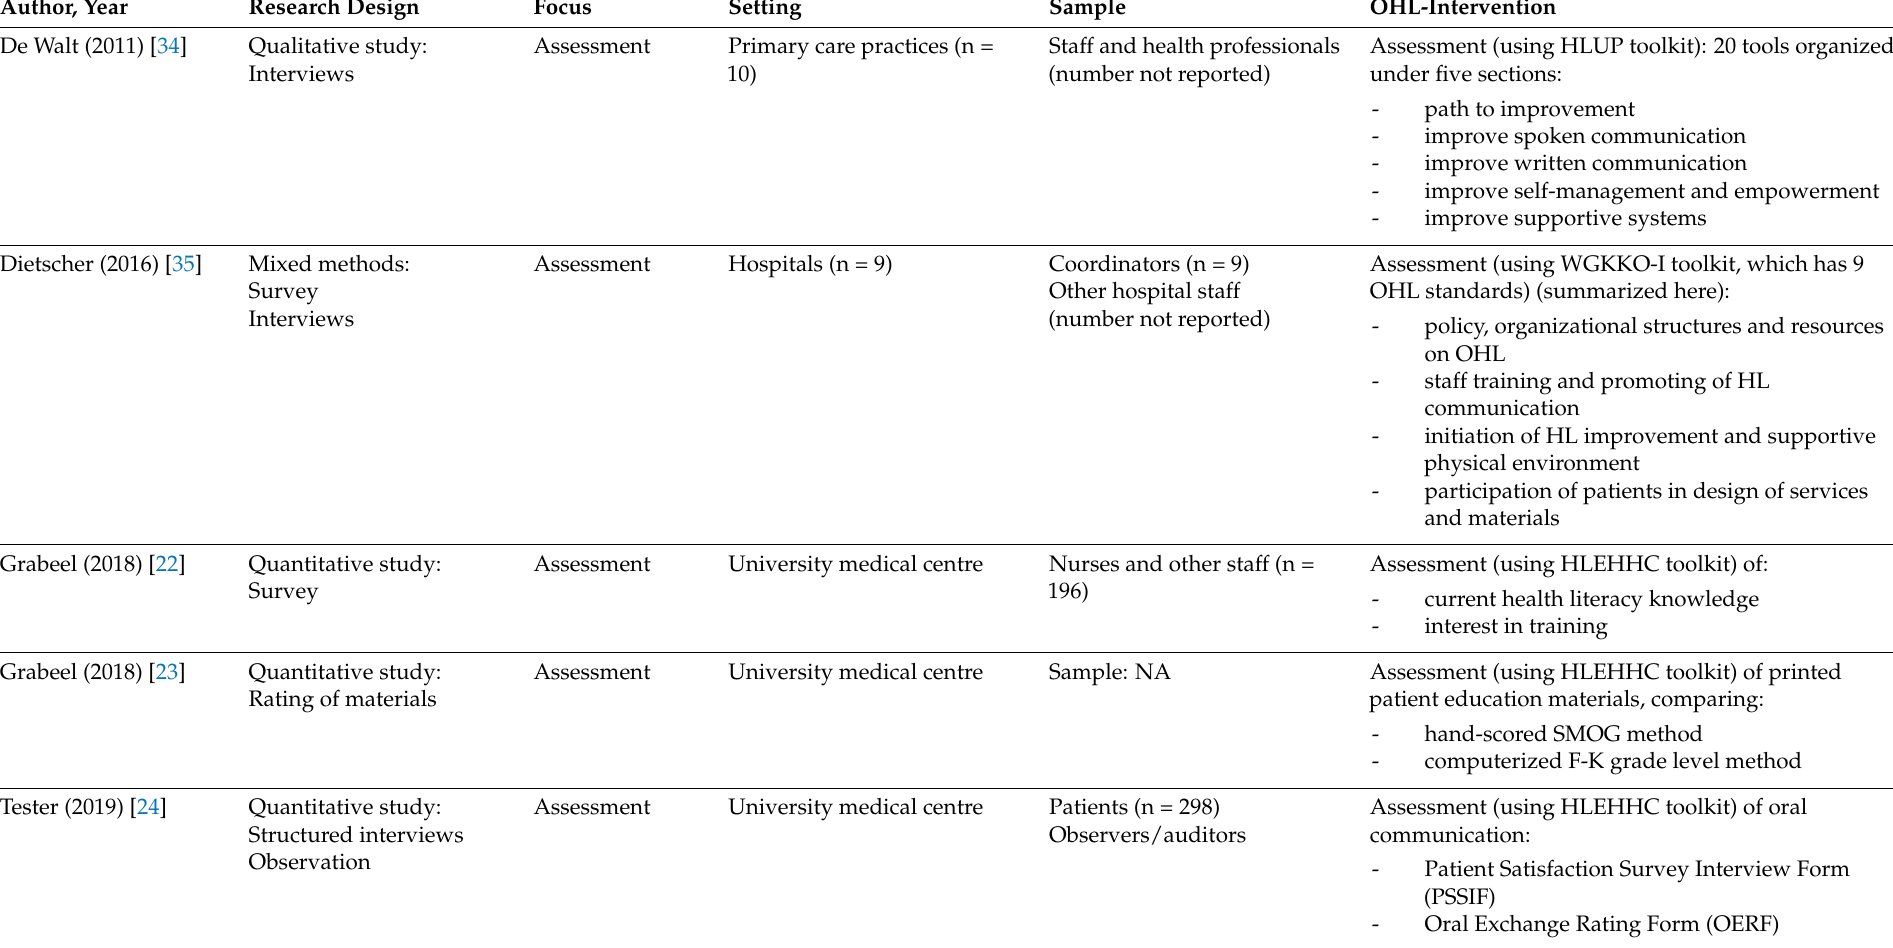
Table 1. Descriptive results of OHL-interventions regarding research design, aim, setting, sample, and